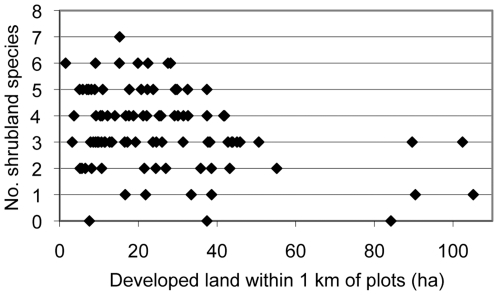
Relationship between the number of shrubland bird species per plot and the area of developed land within 1 km of a survey plot.